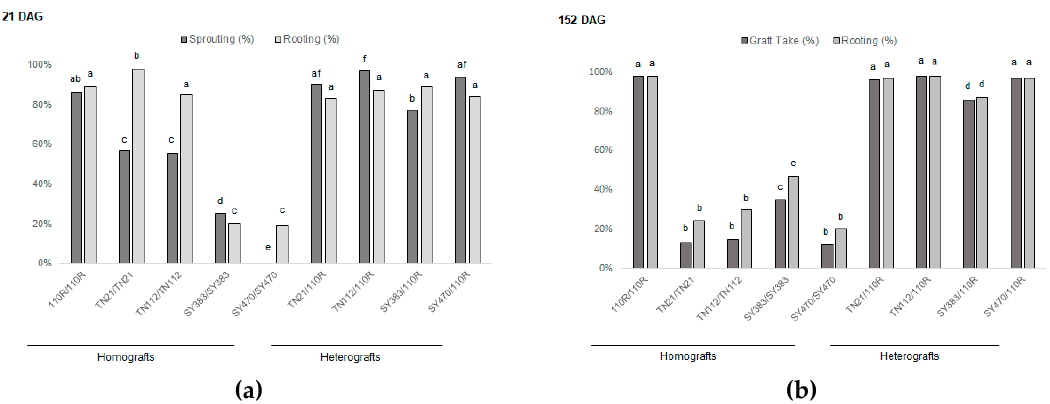
Figure 1. Percentage of graft take, sprouting, and rooting at 21 and 125 DAG in all graft combinations. ( a ) Sprouting and rooting percentages at 21 DAG; ( b ) graft take and rooting percentages at 152 DAG in the same population analyzed at 21 DAG. Different letters indicate significant differences between all graft combinations with p < 0.05 ( n = 94–100 per graft combination) according to Fisher’s exact test.